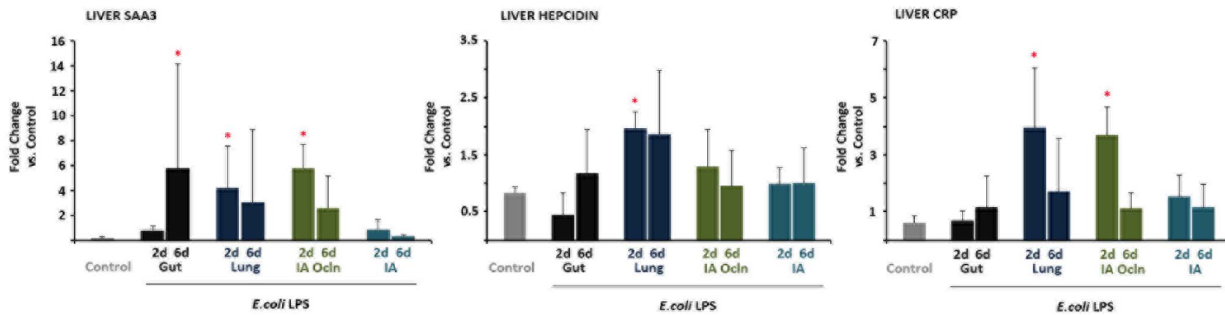
Figure 5. LPS infusion in the gut or the lung or the amniotic fluid induced liver acute phase reactant gene expression. Quantification of messenger RNAs for ( A ) serum amyloid A3 (SAA3) ( B ) hepcidin and ( C ) c-reactive protein (CRP) was performed by real-time PCR assays using sheep- specific primers and hydrolysis probes. Each cytokine was normalized to 18s ribosomal protein mRNA (internal control), and levels for each group were expressed relative to controls as fold increase relative to controls. Liver acute phase response was detected in the 6d ‘‘Gut’’, 2d ‘‘Lung’’ and the 2d ‘‘IA Ocln’’ LPS groups (* p , 0.05 versus controls).